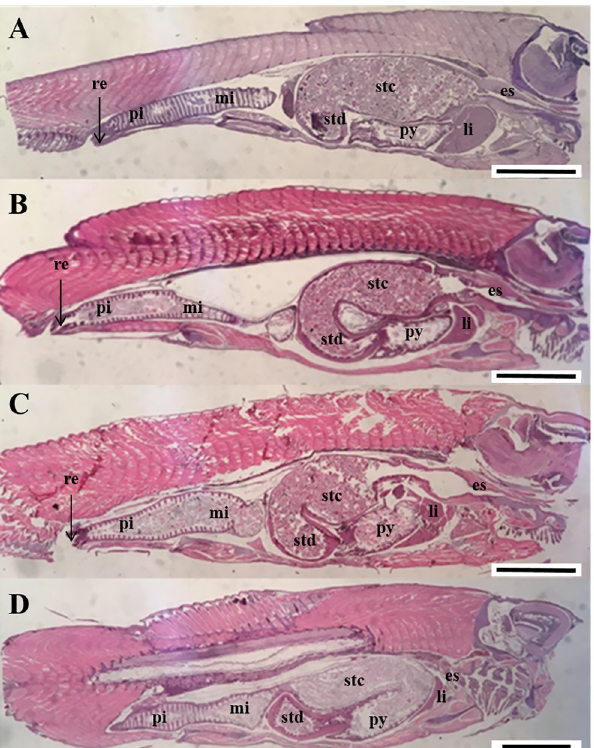
Fig 7. Longitudinal sections of the abdominal part of whole individuals of diploid and triploid Atlantic salmon fed different diets at 218 ddPSF. (A) 2nSTD, (B) 2nHFM, (C) 3nSTD, (D) 3nHFM). es. esophagus; li. liver; mi. mid intestine; pi. posterior intestine; py. pyloric caeca; re. rectum; stc. stomach cardiac; std. stomach posterior. Scale. A-D. 1.88